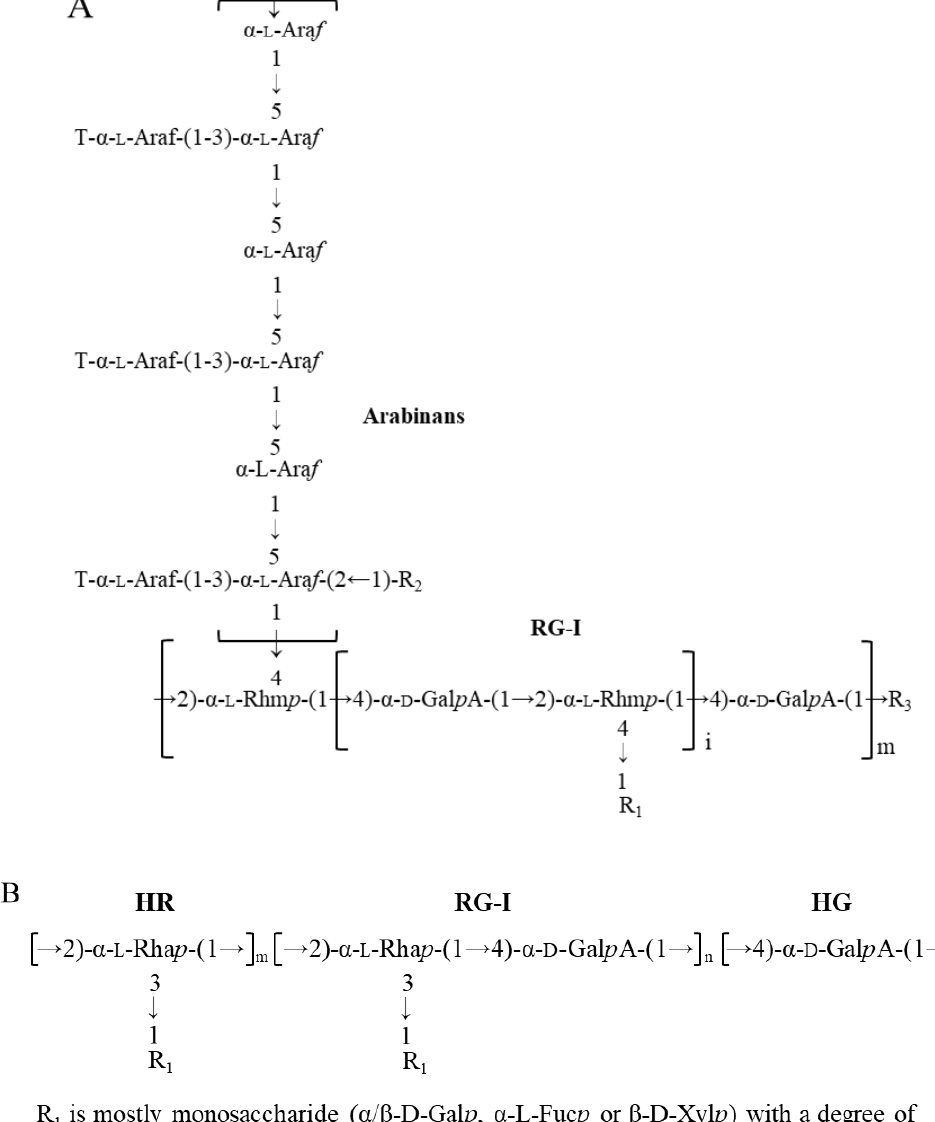
Figure 1. Proposed RG-I structure from flaxseed hulls (( A ), adapted with permission from Ref. [5]) and flaxseed kernel (( B ), adapted with permission from Ref. [4]).